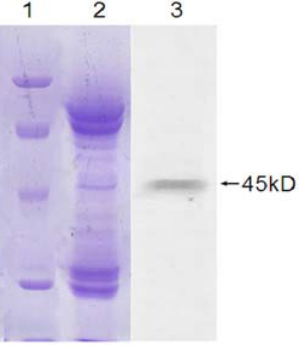
Figure 2. The expression of a 45 kD HA protein of influenza by recombinant Bmgp64HA. The recombinant baculovirus was purified from pupae by four steps centrifugation. Lane M. Protein molecular weight marker. Lane 1. The purified recombinant baculovirus. Lane 3. HA protein expression detected by western blotting.